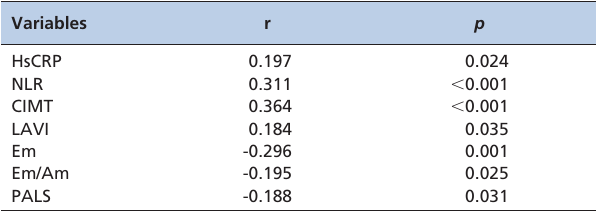
HsCRP: high-sensitivity C-reactive protein; NLR: neutrophil to lymphocyte ratio; CIMT: carotid intima-media thickness; LAVI: left atrial volume index; Em: tissue Doppler mitral annular early diastolic velocity; Am: tissue Doppler mitral annular late diastolic velocity; PALS: peak atrial longitudinal strain.